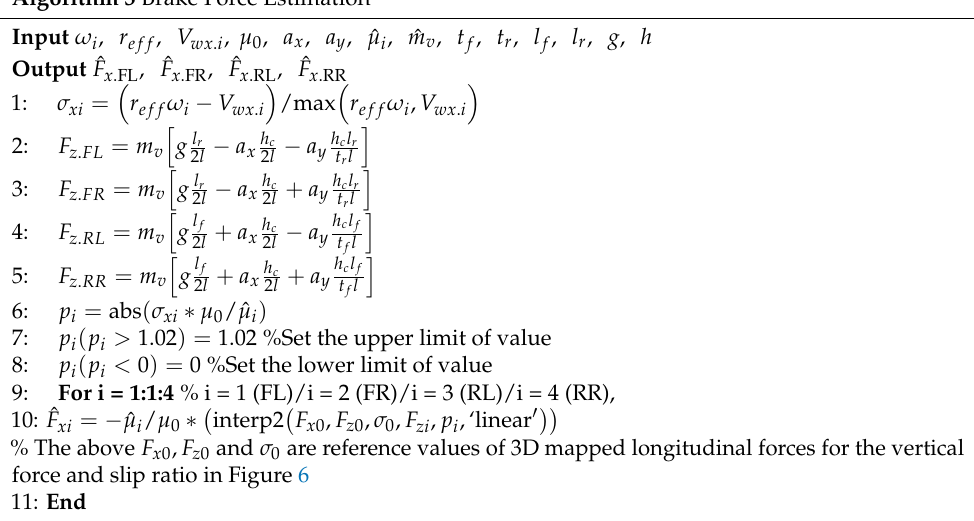
Algorithm 3 Brake Force Estimation